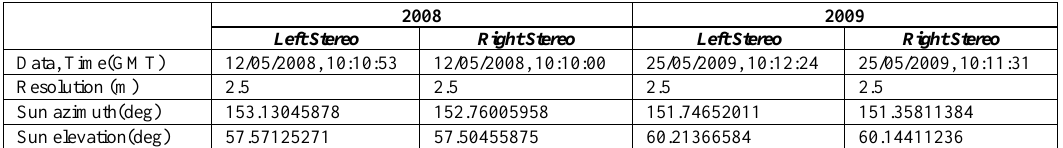
Table 1. Acquisition parameters of the original Cartosat-1 stereo imagery